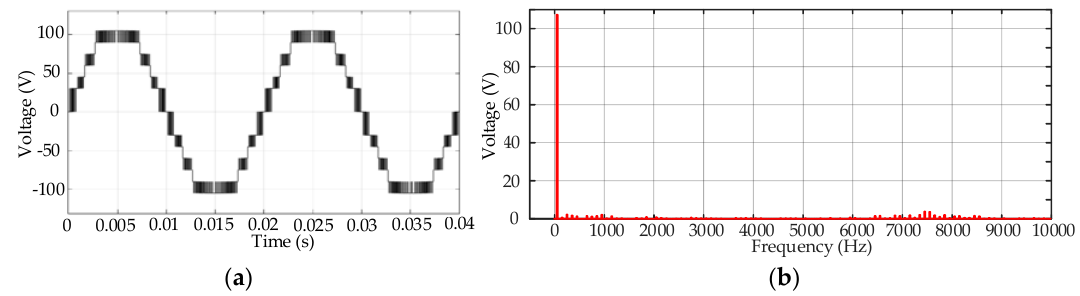
Figure 11. Output of the MLI in Mode II with the introduction of the zero level ( a ) Voltage waveform ( b ) its corresponding harmonics spectra. THD is 9.5%.